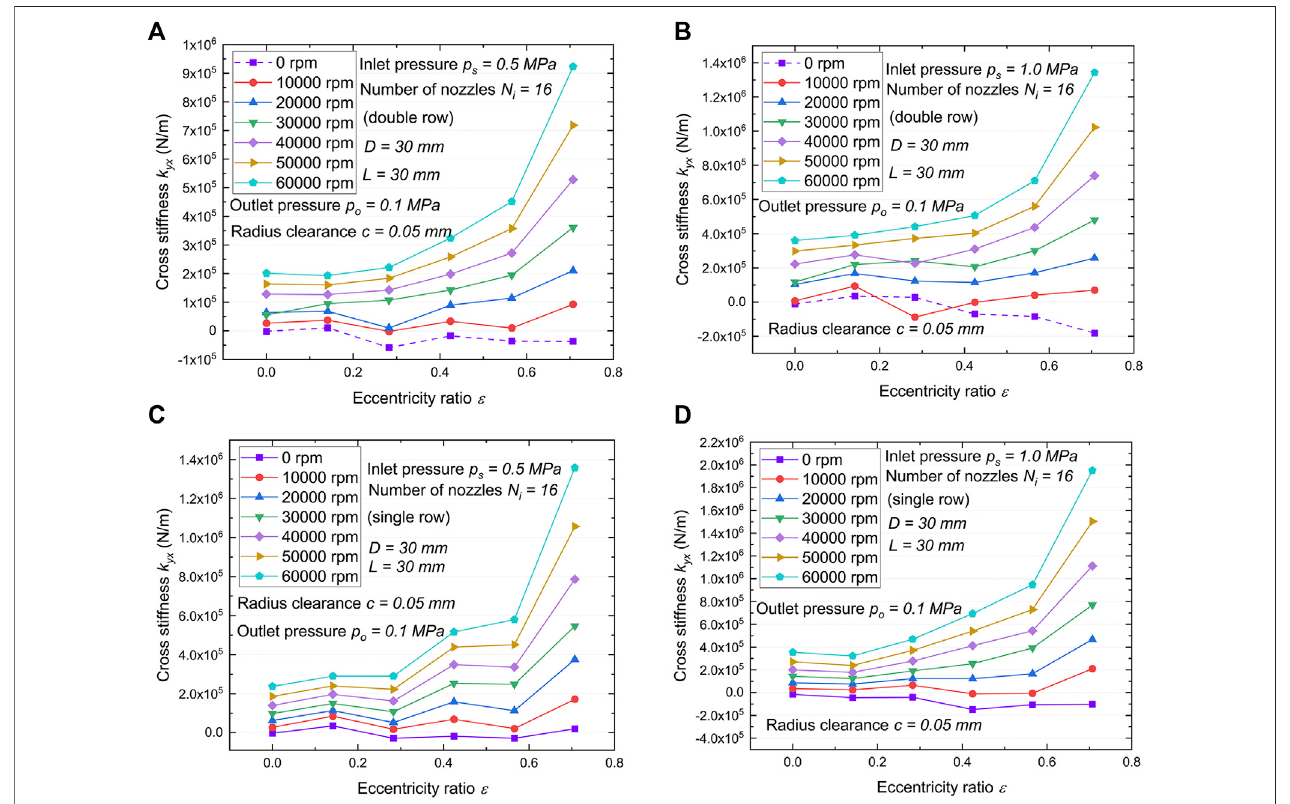
FIGURE11| Variations ofcross stiffnesscoef fi cient k yx witheccentricity ratioversusrotor speed. (A) Double row, p s =0.5 MPa. (B) Double row, p s =1.0 MPa. (C) Single row, p